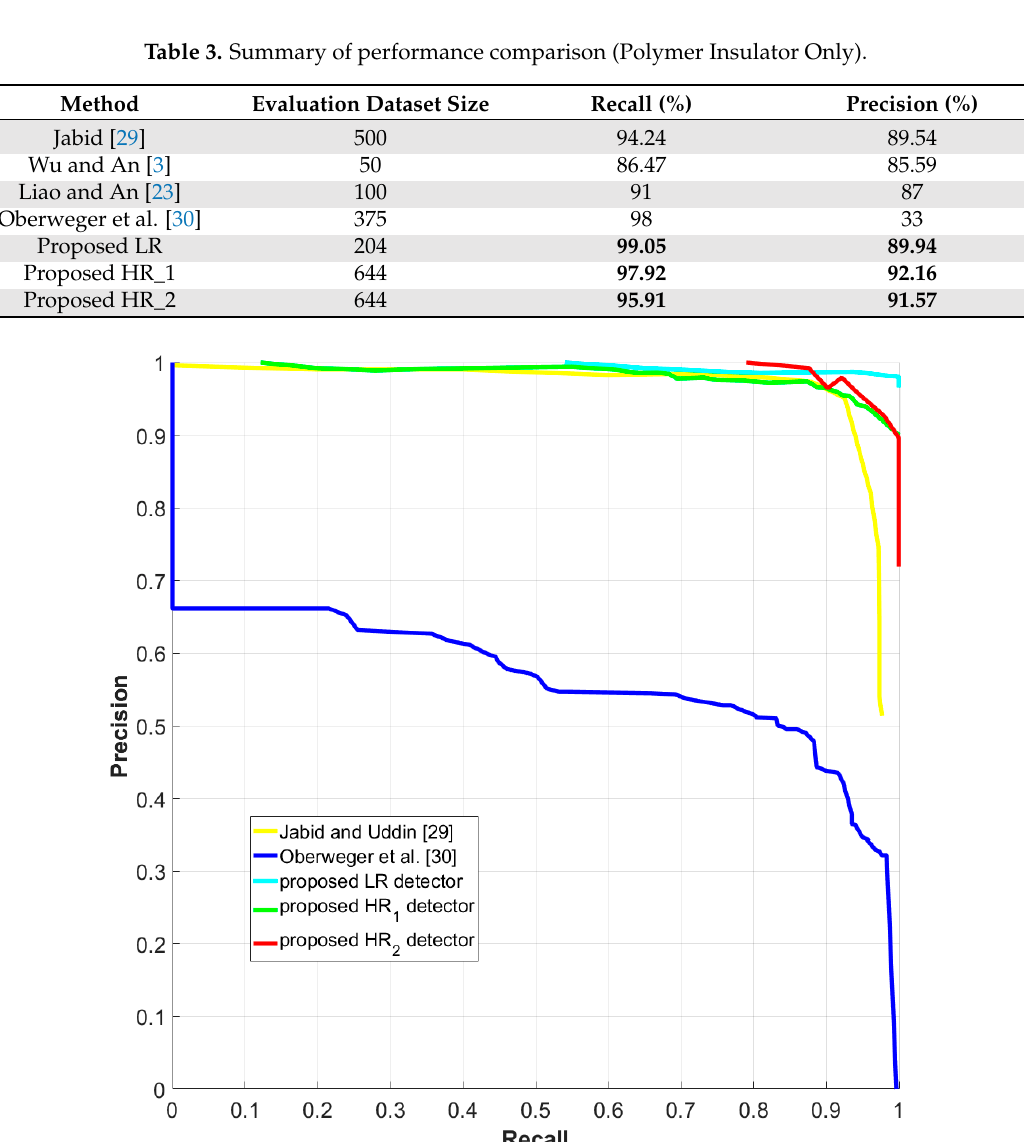
Figure 10. The precision-recall curve for insulator detection. The comparison is drawn between Uddin [29], Oberweger et al. [30], and the three types of CNN-based insulator detectors proposed in this paper.